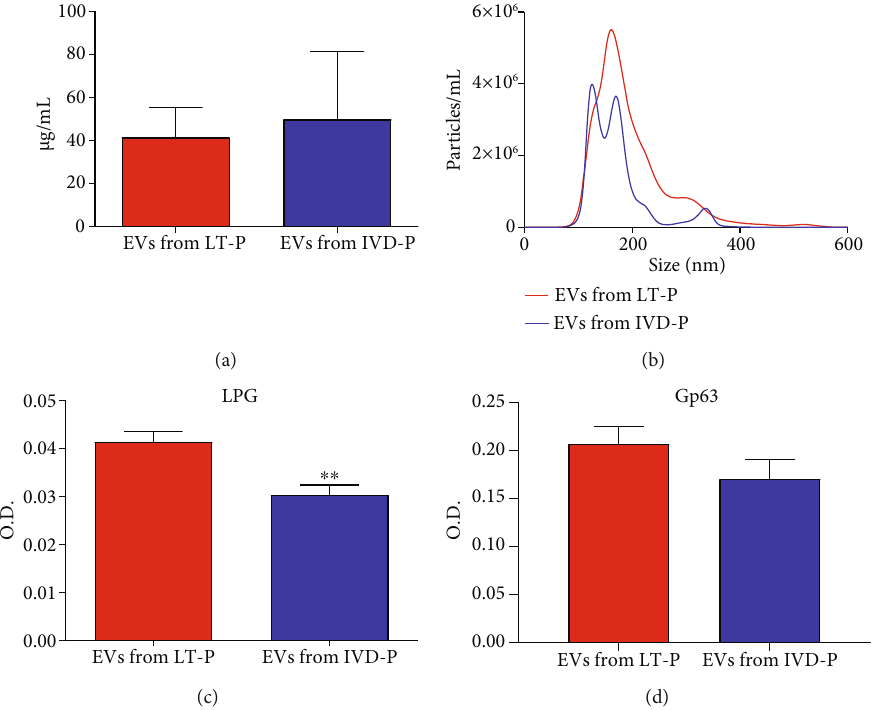
Figure 5: Characterization of EVs released by L. amazonensis promastigotes with distinct virulence pro fi les (IVD-P and LT-P). (a) Protein quanti fi cation ( μ g/mL). Bars represent the average of 3 measurements, and error bars shows the SD. (b) Size pro fi le and concentration (particles/mL) measurements. (c) Detection of LPG and (d) LPG in EVs (4 μ g/sample). Bars denote the average of 3 measurements, and error bars show the SD. Unpaired t -test ∗∗ P < 0 : 01